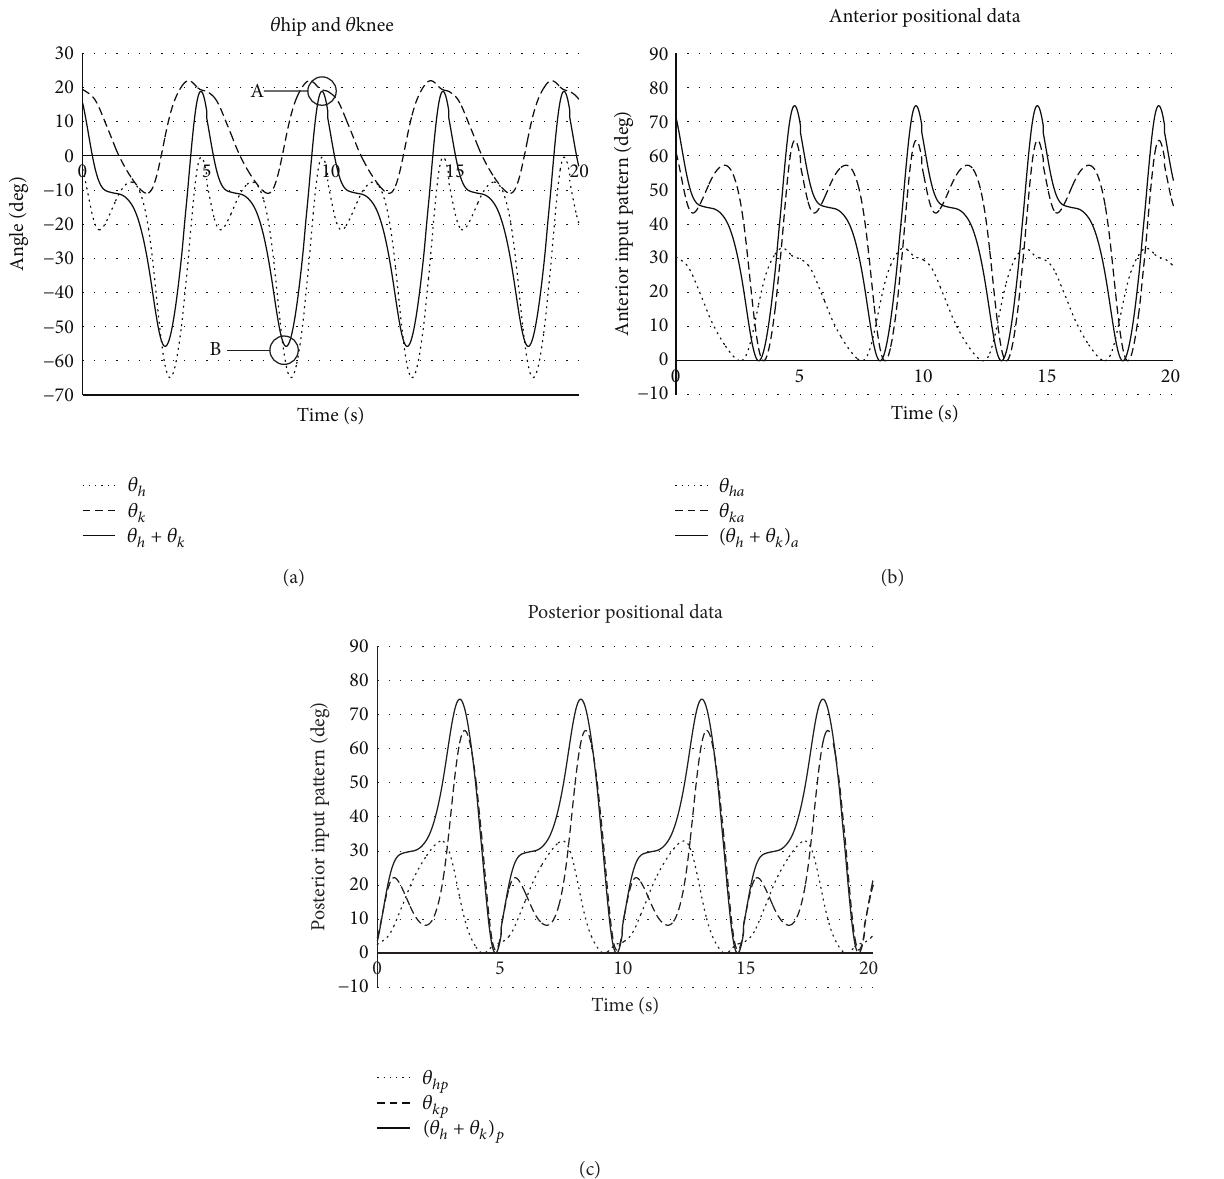
Figure 7: Input patterns of the antagonistic mono- and bi-articular actuators. 𝜃 ℎ is the hip joint angle; 𝜃 𝑘 is the knee joint angle; 𝜃 ℎ𝑎 , 𝜃 𝑘𝑎 , and + 𝜃 ) (𝜃 ℎ 𝑘 𝑎 are the positional data for the anterior actuators; and